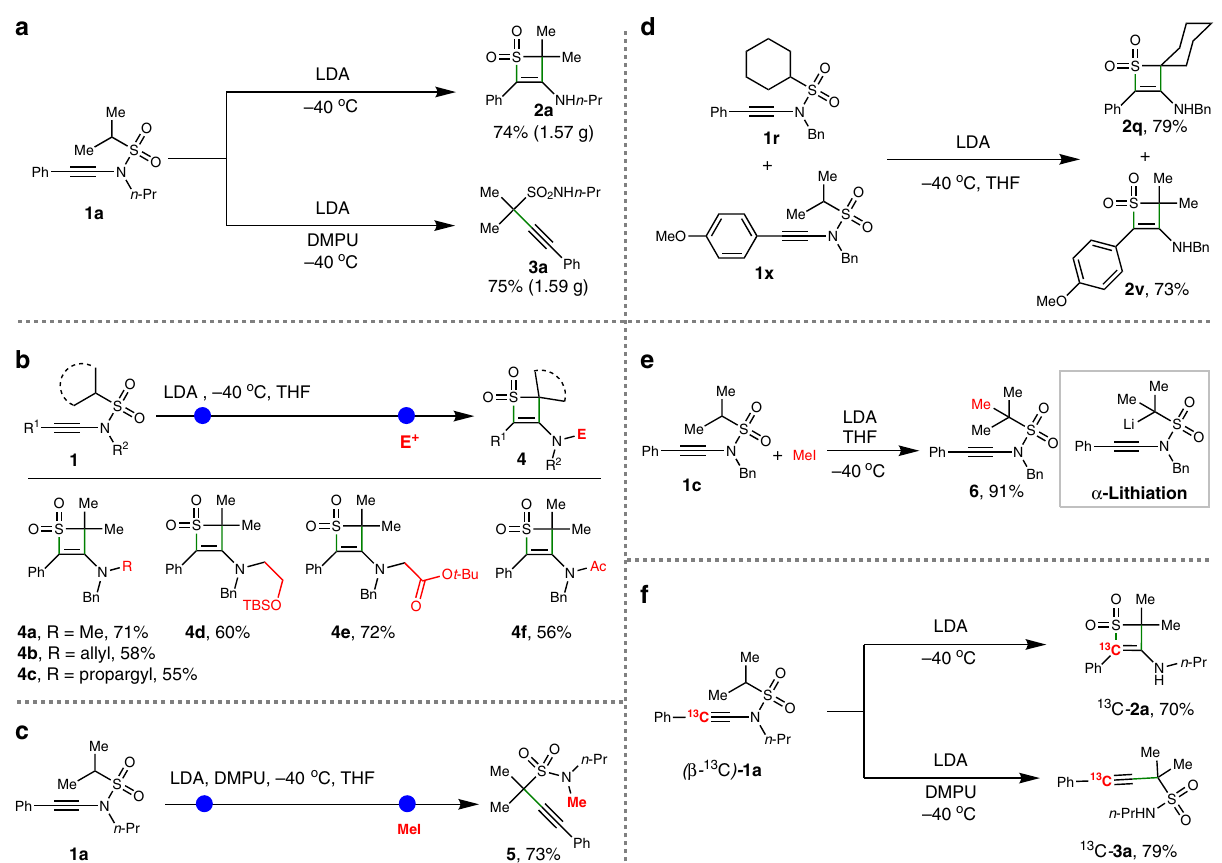
Fig. 6 Synthetic applications and mechanistic experiments. a Gram-scale reaction of ynamide 1a . b Electrophilic reagents-quenched reorganization toward N -functionalized thiete sulfones 4 . c MeI-quenched reorganization toward N -methyl propargyl sulfonamide 5 . d Crossover reaction. e α - Methylation experiment. f 13 C-Labelled experiment.